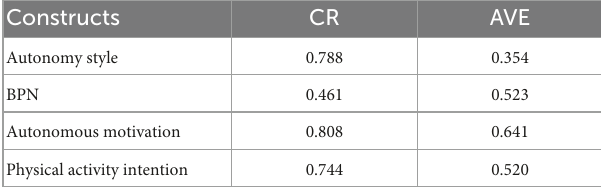
TABLE 2 Convergent and discriminant validity of the